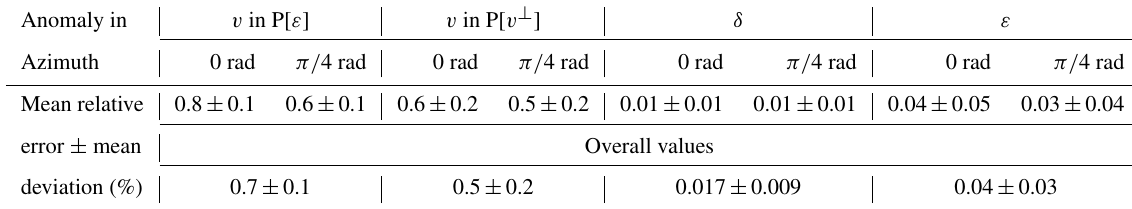
Table 2. Mean relative travel-time errors in percentage and their mean deviations for the two selected meridians in Fig. 3 and for the entire set of 482 source–receiver pairs. Compared to Fig. 2a–b, these average travel-time error values indicate that the code is sufficiently accurate to model the travel-time residuals arising from the inclusion of the selected anomalies. Anomaly in v in P[ ε ] v in P[ v ⊥ ] δ